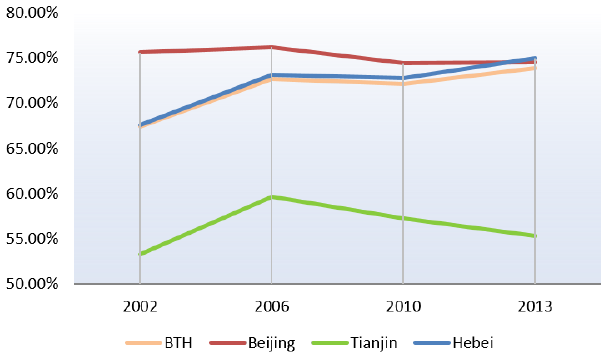
Figure 8. The curve of FVC in BTH Region from 2002 to 2013.